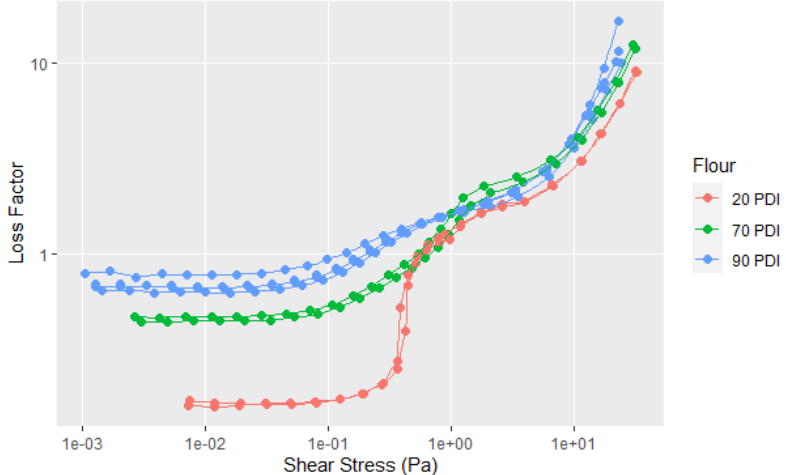
Figure A8. All replicates for samples shown in Figure 9.